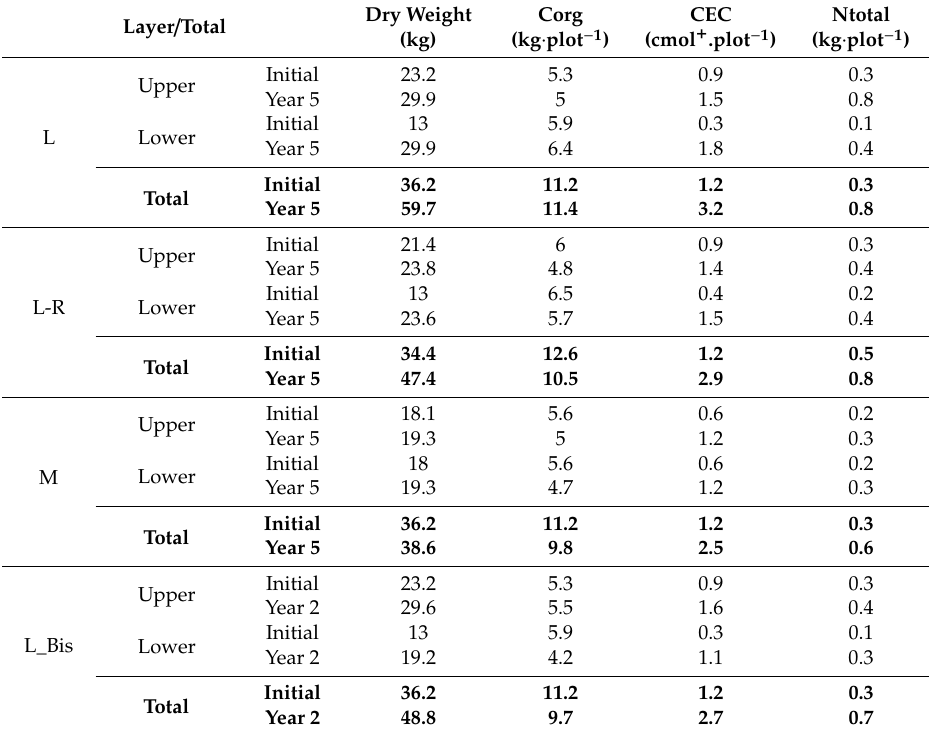
Table5. EstimatedmassofTechnosolandstockofnutrientsperplot(0.64m 2 ). Initialstocksarecalculated from concentrations in the parent materials and bulk densities when setting up the